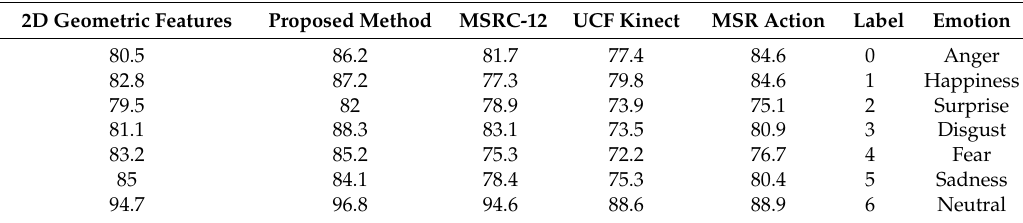
Table 7. Precision comparison for multimodal emotion recognition.